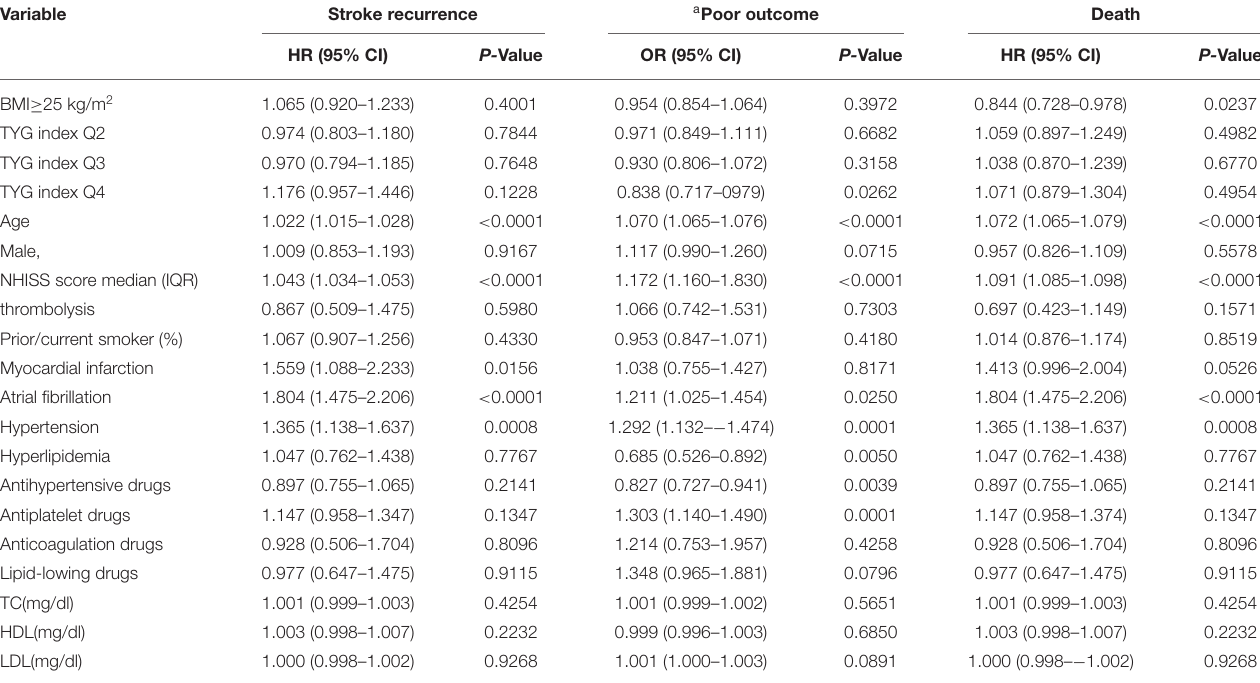
TABLE 5 | Multivariate analysis of BMI and TYG index on stroke outcome.